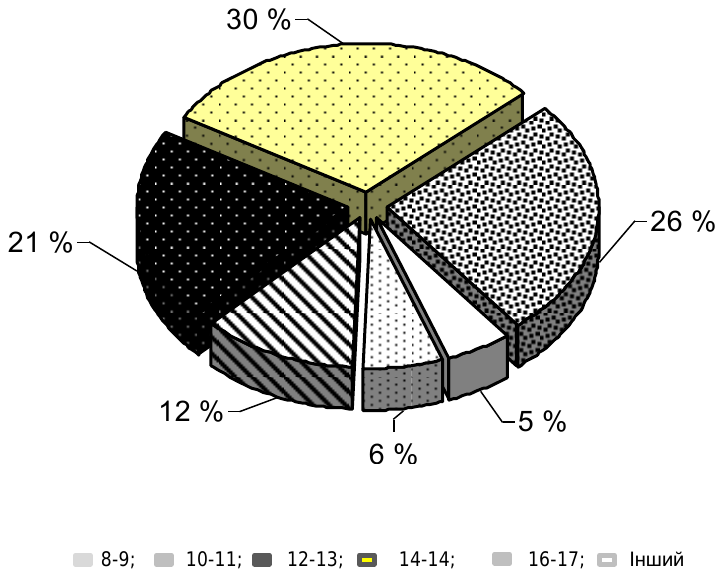
Fig.5. The most favorable age for starting of individualized psychological training of tennis players (by data of experts’ questioning,